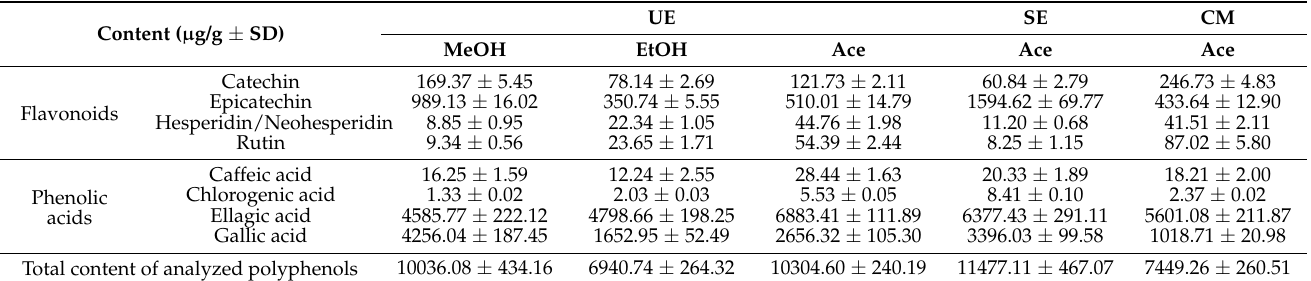
Table 2. Polyphenol components in lyophilized PP extracts obtained by ultrasonic extraction (UE), Soxhlet extraction (SE), and cold maceration (CM).